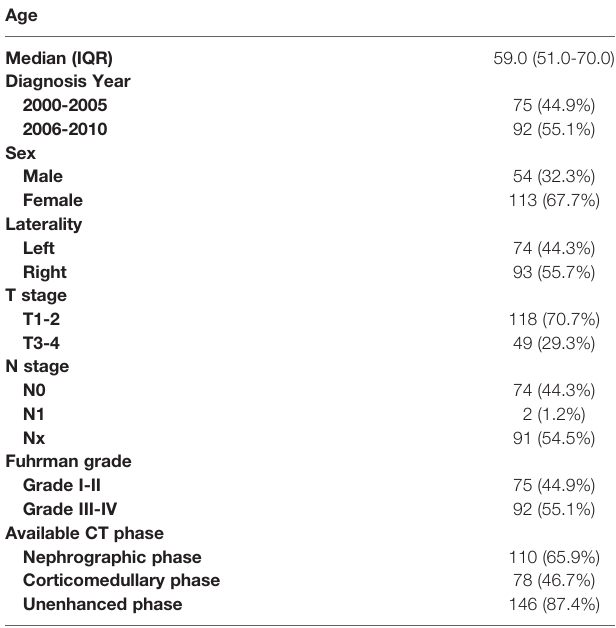
TABLE 1 | Baseline characteristics of the total patients included in the current